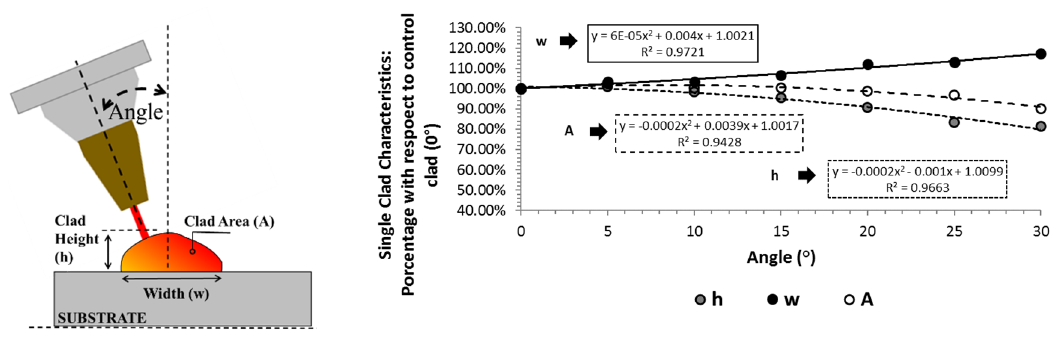
Figure 9. Effect of the head tilting on the single clad characteristics. Adapted from “Effects of Gravity and Non-Perpendicularity during Powder-Fed Directed Energy Deposition of Ni-Based Alloy 718 through Two Types of Coaxial Nozzle”, by Ramiro et al. [25].